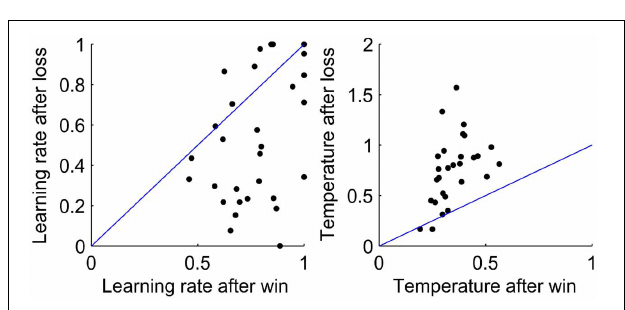
FIGURE 5 | Parameters estimated by the WL model for data simulated using the WL model with parameter values as shown by crosses. Left: Learning rate. Right: Temperature. Lines show equality of the parameters after a win and after a